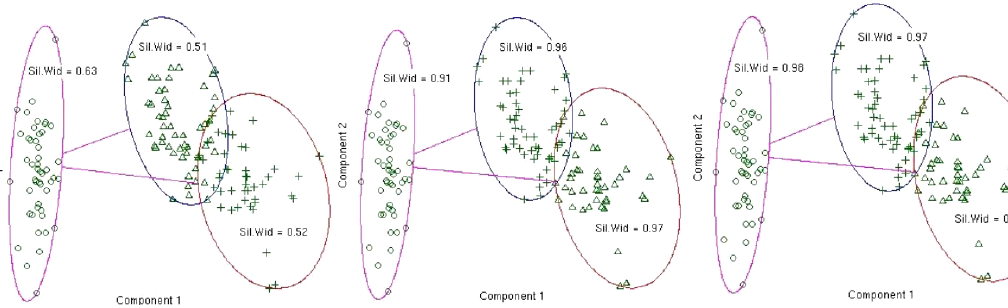
Fig. 18. IRIS Dataset: (i) Result by KFCM (ii) Result by KEFCM wd (iii) Result by KFCM nt .